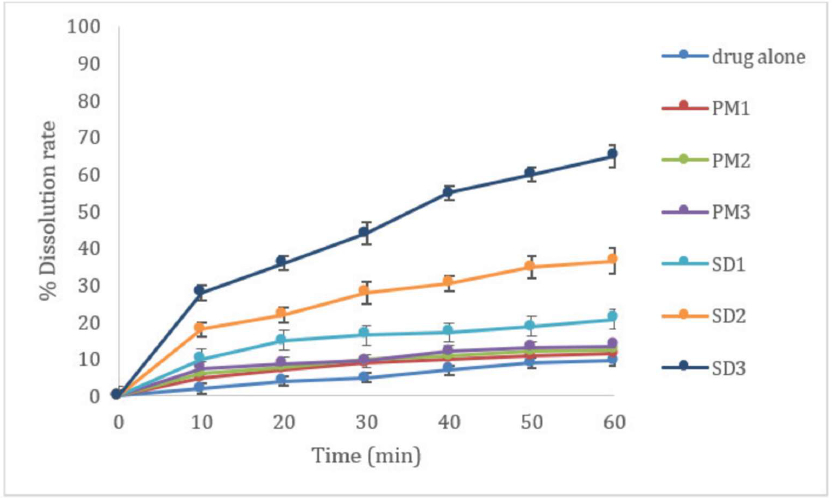
Figure 3. Enhancement of dissolution profile of Clonazepam/HPMC K4000 PMs and SDs.